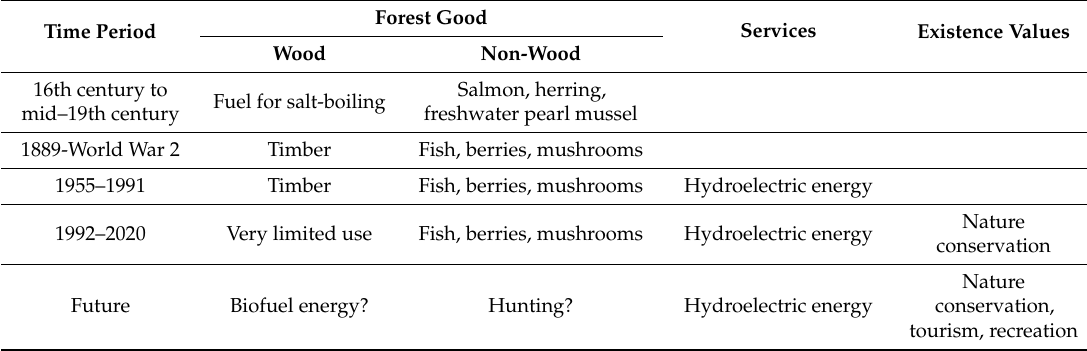
Table 2. Forest products based on boreal forest landscapes’ goods, services and values [33] of the Kovda River catchment during different time periods.